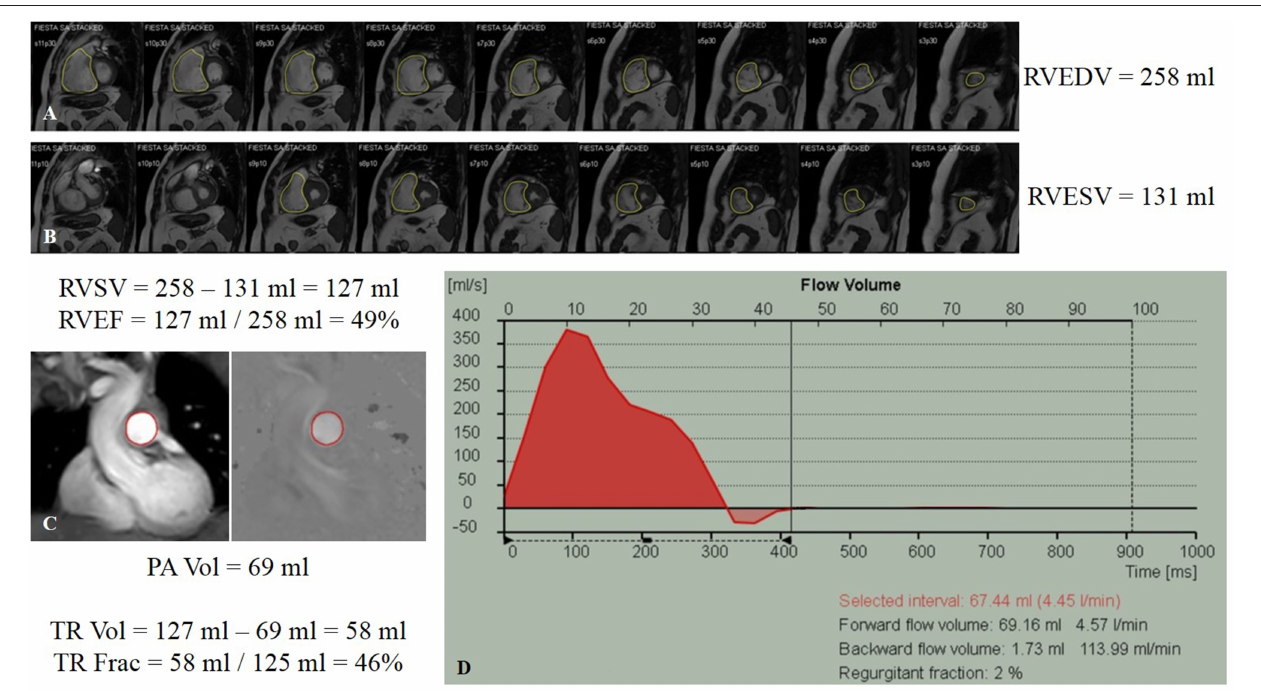
FIGURE 7 | Cardiac magnetic resonance volumetric and flow analysis of a patient with group 3 pulmonary hypertension. (A) Steady-state free precession cine imaging stack in the short-axis view displayed from base (left) to apex (right) at end-diastole (A) and end-systole (B) . The endocardium of the right ventricle has been traced (yellow contours) with signs of septal straightening and change from a crescent contour to a more rounded contour. The slice contours have been summated, showing right ventricular end-diastolic and end-systolic volumes, and the calculated right ventricular ejection fraction. (C) Phase-contrast (PC) imaging performed through the proximal pulmonary artery (red contours) with magnitude- (left) and phase- (right) encoded images in corresponding spatial orientation. (D) Flow-time curve showing the volume detected in the pulmonary artery. Indirect determination of tricuspid regurgitation volume involving subtraction of the pulmonary artery flow volume derived from PC imaging from the calculated right ventricular stroke volume, as well as the tricuspid regurgitant fraction. Frac, fraction; PA, pulmonary artery; RVEDV, right ventricular end-diastolic volume; RVEF, right ventricular ejection fraction; RVESV, right ventricular end-systolic volume; RVSV, right ventricular stroke volume; TR, tricuspid regurgitation; Vol,